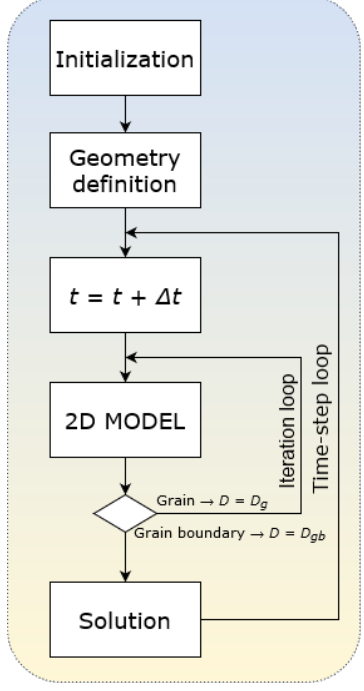
Figure 1. Schematic presentation of the solver.